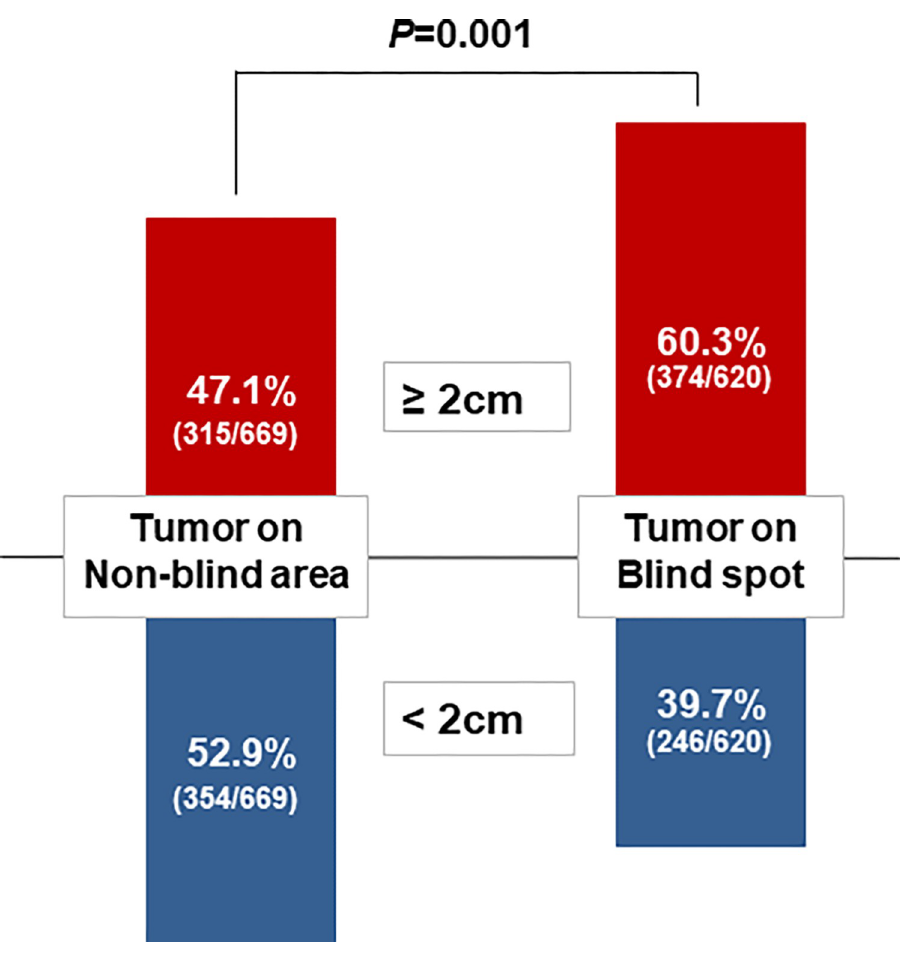
Fig 2. Comparison of the size distribution of HCC by blind vs. non-blind spot location. HCC, hepatocellular carcinoma. 1.636; P = 0.028), and HCC missed by US (OR, 2.177; 95% CI, 1.581–2.998; P < 0.001) were independent factors associated with a blind spot tumor location. Impact of blind spot tumor location on initial treatment of HCC by tumor size Of the total 1,289 patients, 1,008 (78.2%) underwent initial curative treatment (hepatectomy, radiofrequency ablation [RFA], or liver transplantation) during the study period (Table 4) . The proportion of patients who received curative treatment did not significantly differ between blind spot and non-blind location regardless of HCC size (78.1% vs. 78.3% for any size, P = 0.910; 76.4% vs. 77.7% for HCCs < 2 cm, P = 0.717). A significantly higher proportion of patients with tumors located within blind spots under- went hepatectomy than those with tumors in non-blind areas; in contrast, patients with HCC tumors located in non-blind areas were more frequently treated with RFA. These trends were maintained in patients with HCC detected by US. In the US-missed group, RFA was more fre- quently performed for HCC tumors located in non-blind areas than in blind spots regardless of size (29.6% vs. 13.0% for any size, P = 0.002; 46.5% vs. 21.9% for HCC < 2 cm, P = 0.007).